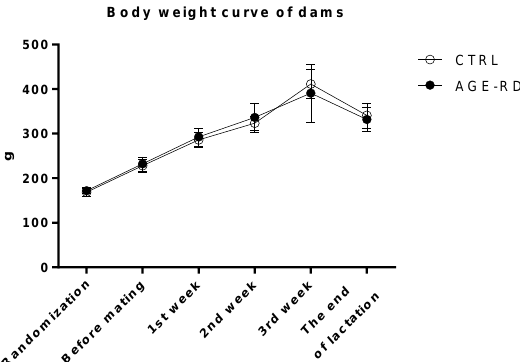
Figure 1. Body weight in F0 generation dams. No significant difference in body weight of dams consuming a standard diet (CTRL) or a diet rich in advanced glycation end products-rich (AGE-RD) from randomization till the end of lactation has been observed. Data are presented as mean ± standard deviation (SD).